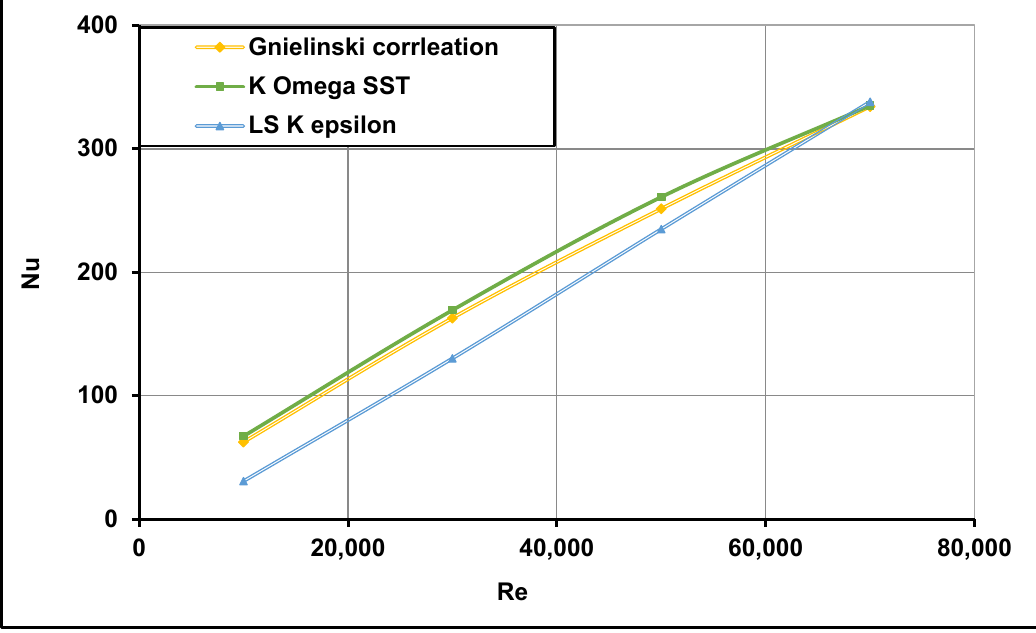
Table 5. Comparisons of the output temperature of the working fluid.